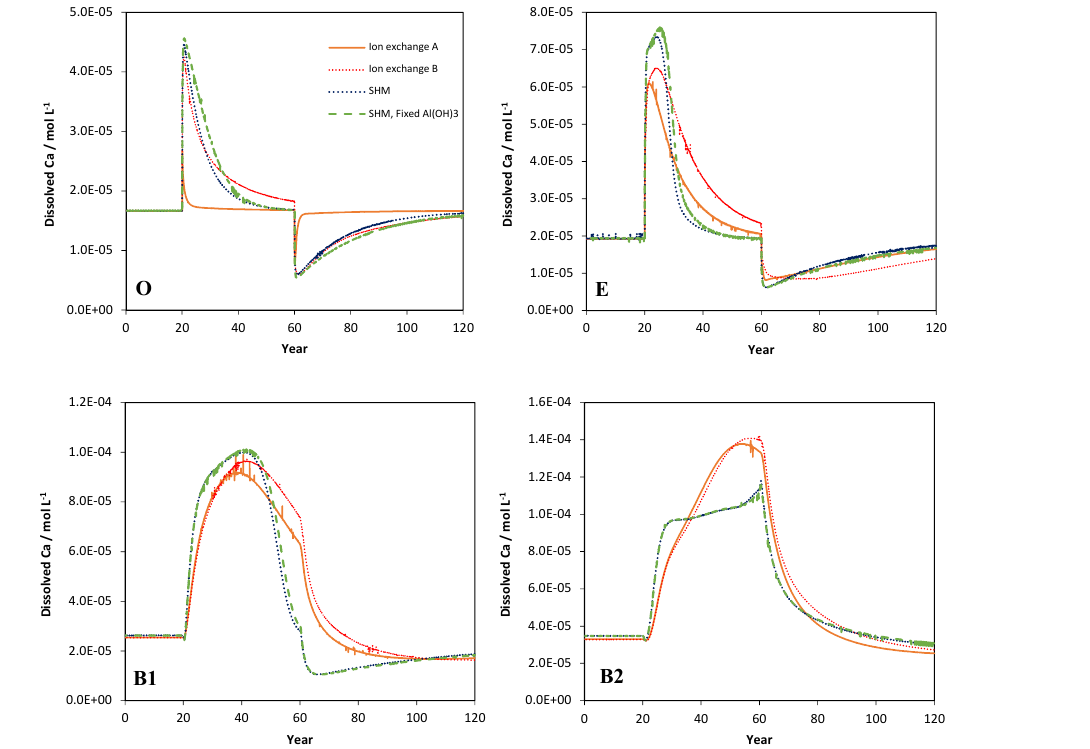
Figure 2. Simulated values of dissolved Ca in the four soil layers (O, E, B1, B2) as a function of time for the four models considered in the Acid scenario. For model set-up and scenario parameters, see